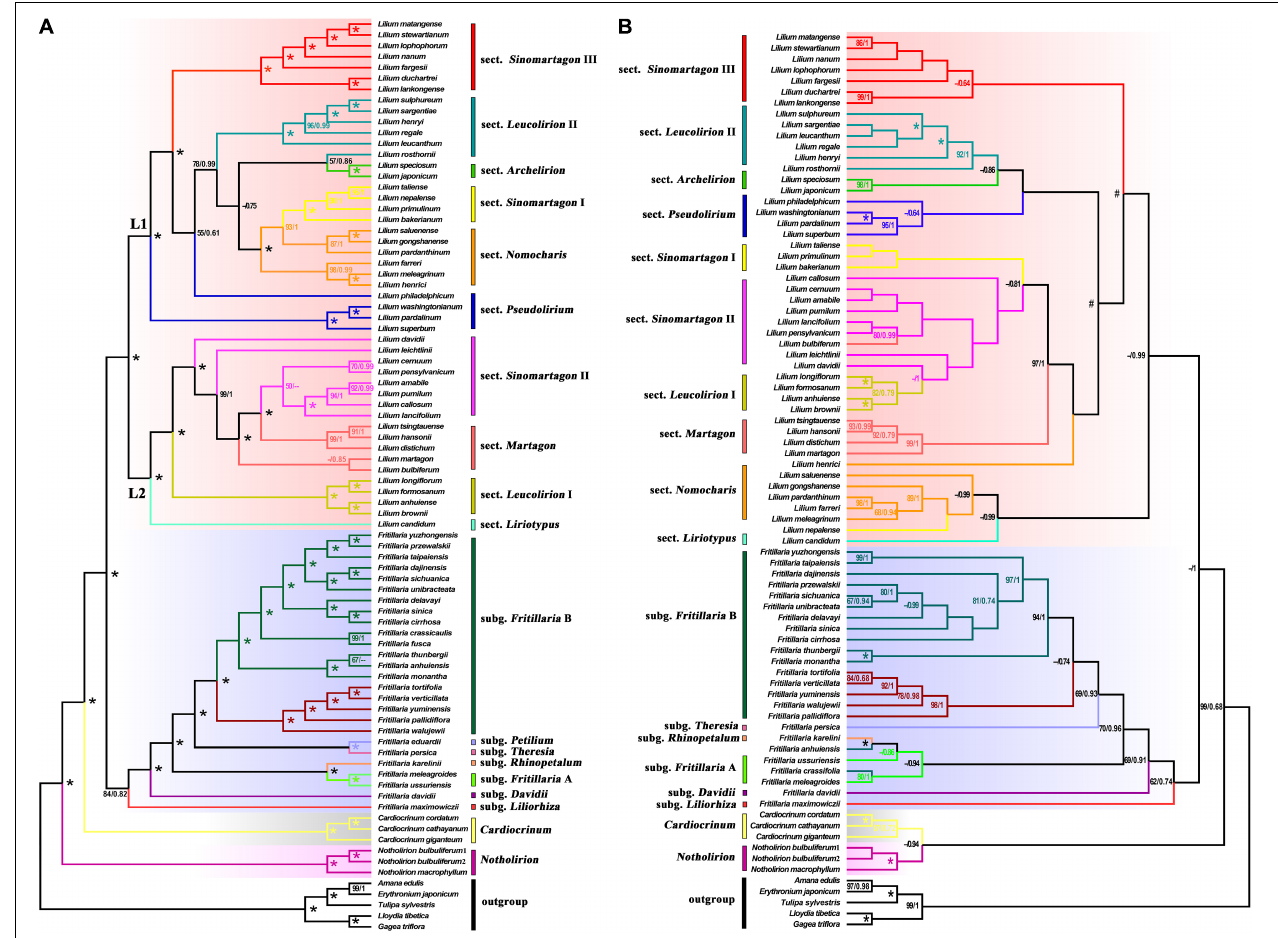
FIGURE 1 | Phylogenetic relationships of Lilieae species inferred using whole plastomes (WP) and nuclear ribosomal internal transcribed spacer (ITS) sequence data. Maximum-likelihood bootstrap support/Bayesian posterior probability values are shown near corresponding nodes (“-” indicates support values less than 50%; “*” represents 100%/1 support). The genus, subgenus, and sectional classifications of Lilieae are indicated to the middle of trees and colored within trees. (A) Phylogenetic relationships inferred from WP data and (B) Phylogenetic relationships inferred from ITS